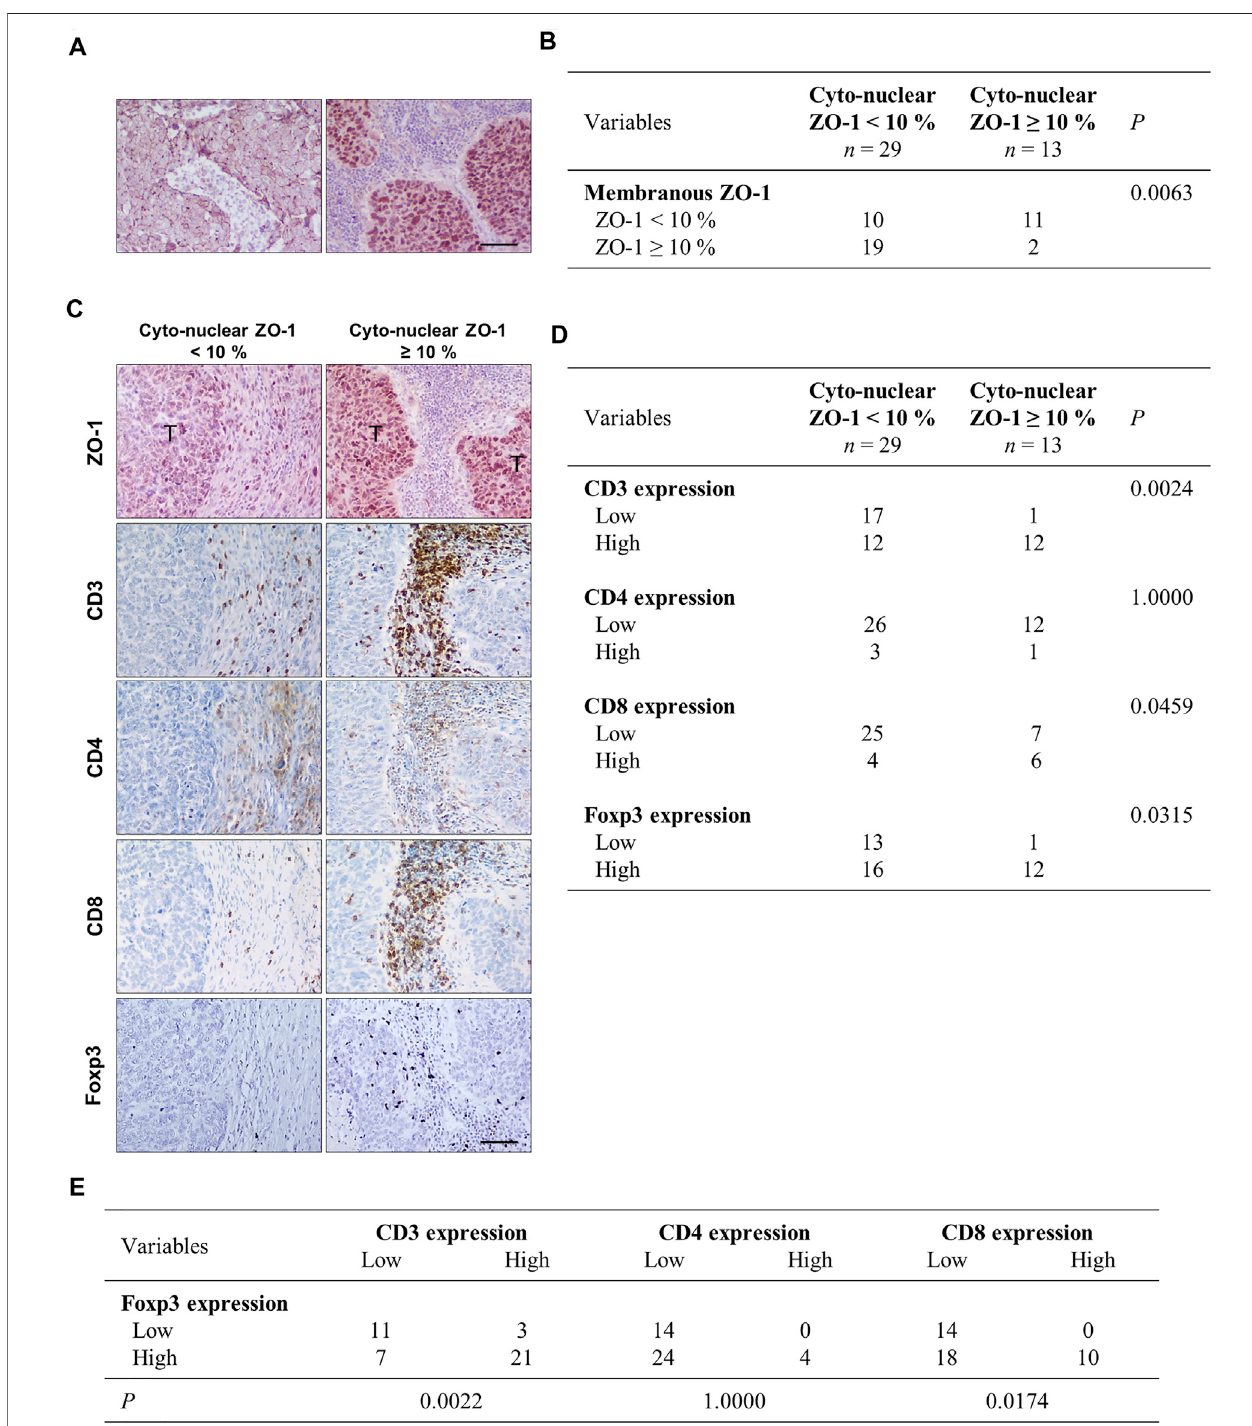
FIGURE 3 | Cyto-nuclear localization of ZO-1 in tumor cells is associated with cytotoxic T cells and immunosuppressive cell recruitment in the tumor microenvironment in human lung cancers. (A) Immunohistochemistry of ZO-1 illustrating a membrane-associated ZO-1 staining (left panel) and a cyto-nuclear ZO-1 labeling (right panel) in human NSCL cancers. (B) Statistical analysis of associations between cyto-nuclear and membranous ZO-1 distribution. 42 human NSCL carcinomas were analyzed. Samples were scored for membrane-associated and cyto-nuclear ZO-1 distribution as detailed in the material and methods section. The numbers of cases falling in the different groups are given in the table. (C) Immunohistochemistry analysis showing ZO-1, CD3, CD4, CD8, and Foxp3 staining on serial sections ofthe NSCLC tumor samples. (T)indicates tumor clusters. Scale bar (cid:2) 80 µm. (D) Statistical analysis ofassociations between cyto-nuclear localization of ZO-1 and Foxp3 and CD3, CD4, CD8 in NSCLC. (E) Statistical analysis of associations between Foxp3 and CD3, CD4, CD8 in the NSCLC samples.